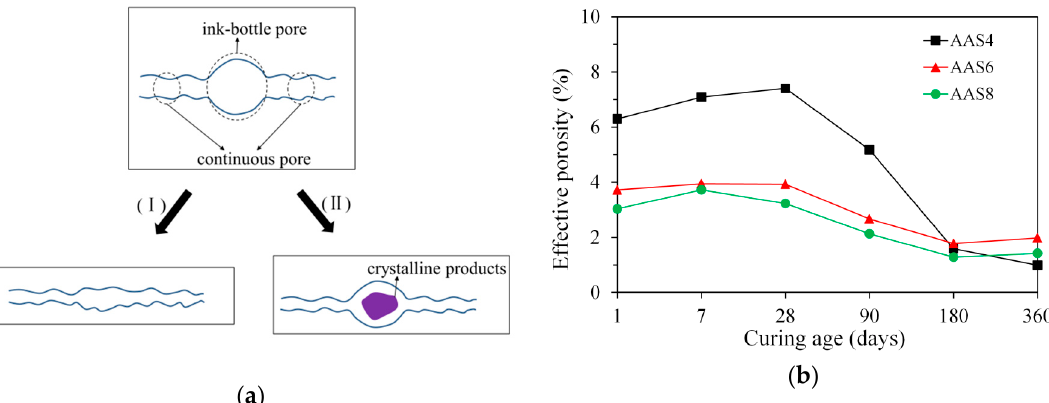
Figure 15. Schematic illustration of the transformation of ink-bottle pores into continuous pores ( a ), and effective porosity of samples for AAS4, AAS6, and AAS8 ( b ). In the graph ( b ), AAS indicates alkali-activated slag, and the number following AAS refers to the weight percentage of Na 2 O with respect to slag. For all samples, the water to slag ratio was 0.4 and the curing temperature was 20 °C.